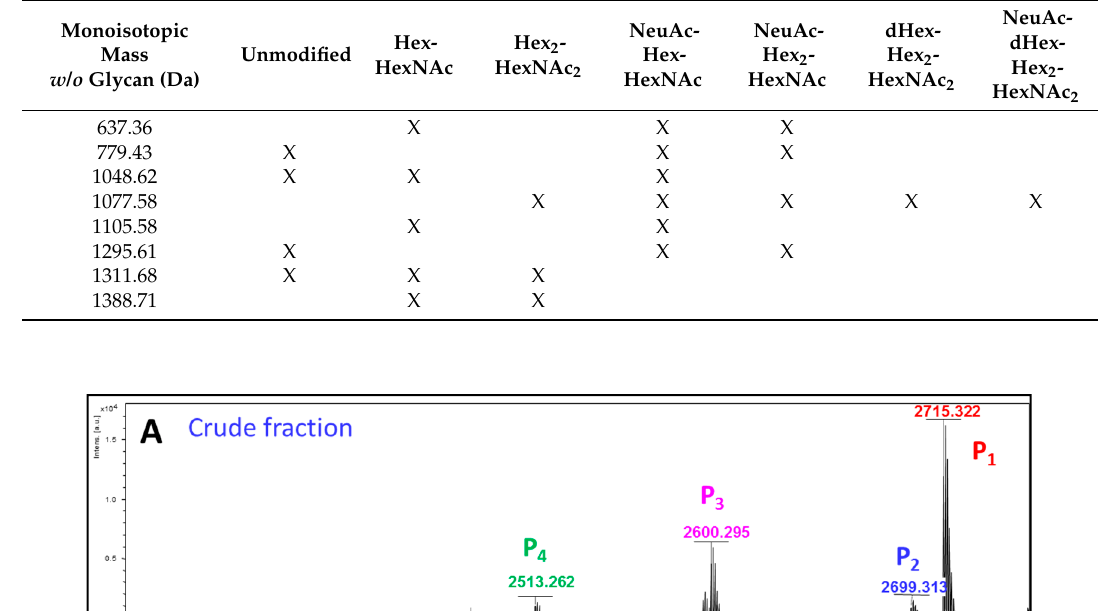
Table 2. Glycoform diversity observed for different peptides.